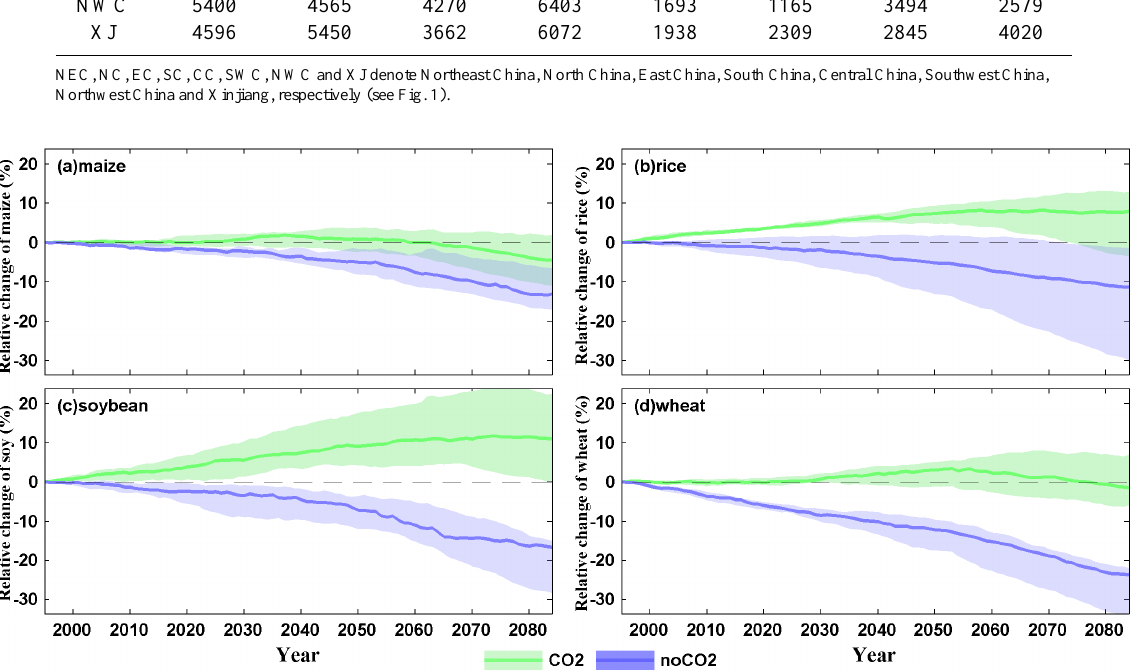
Figure 3. The relative change in the yield of maize (a) , rice (b) , soybean (c) and wheat (d) in China under RCP8.5. The blue (green) shaded area denotes the interquartile range for the simulations with (without) the CO 2 effect and the solid line shows the median of the GCM–GGCropM